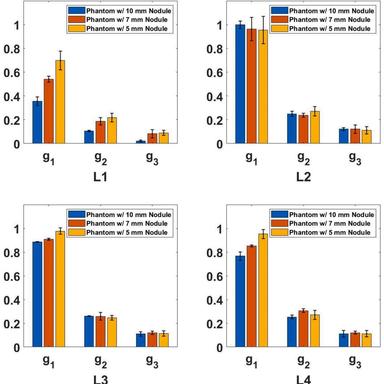
QLV parameters at different locations of the prostate phantom during palpation experiments using the test rig and compression procedure seen in. Compression was performed at the indentation depth of 5 mm and a rate of 10 mm/s following the indentation profile depicted in a. 95% confidence interval are represented by the error bars.